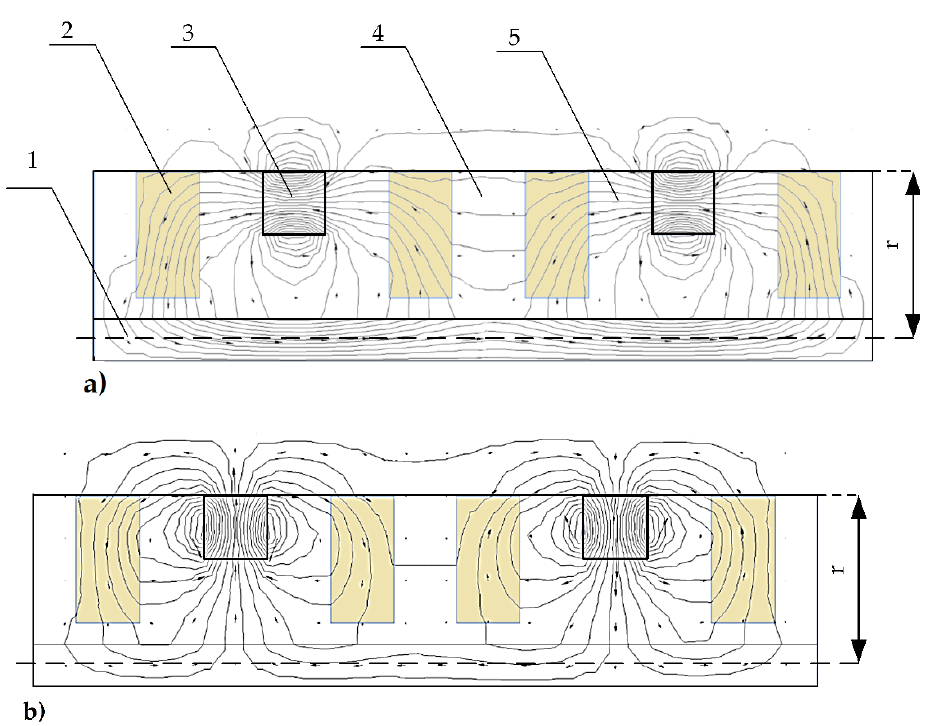
Figure 6. Magnetic potential lines (1 × 10 -6 Wb interval) and magnetic flux density vectors: ( a ) Unidirectional axial orientation (see also Figure 5b). ( b ) Differential radial orientation (see also Figure 5e).